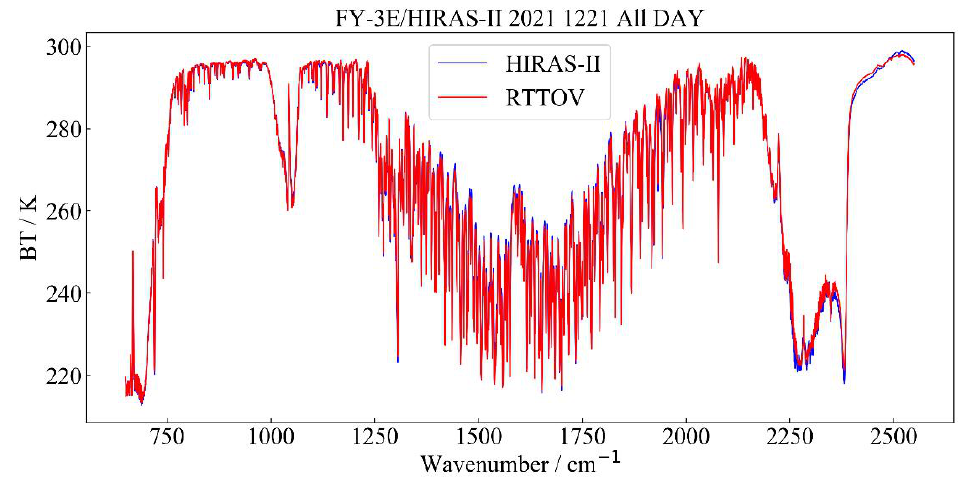
Figure 5. Comparison of FY-3E/HIRAS-II observed and simulated brightness temperature.